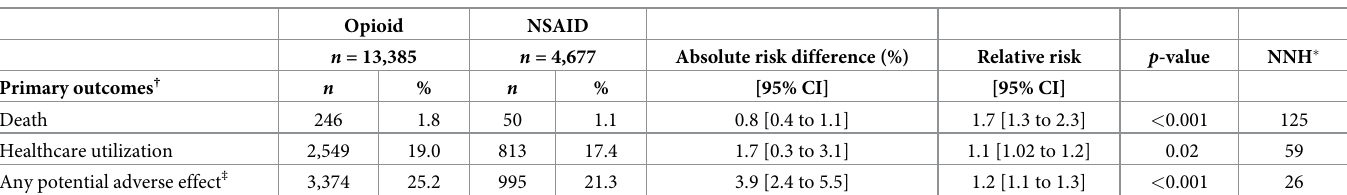
Table 2. Outcome incidence, absolute risk difference, and relative risk for opioids compared to NSAIDs in the propensity-matched cohorts ( n = 18,062). Opioid NSAID